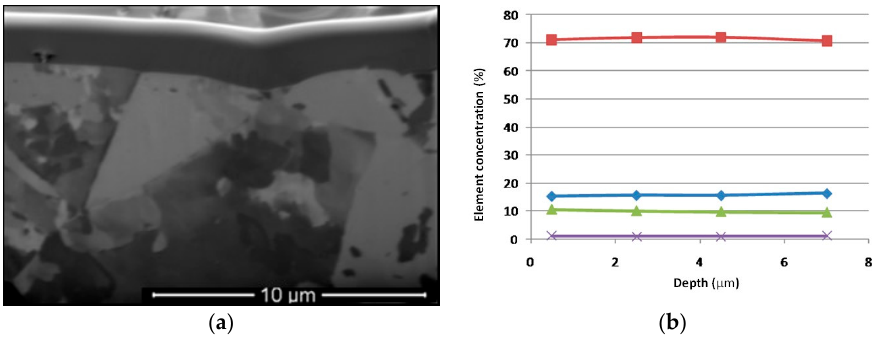
Figure 12. ( a ) Cross section SEM image (10,000×) and ( b ) EDX chemical analysis of SS 316L sample after 2500 h heating.